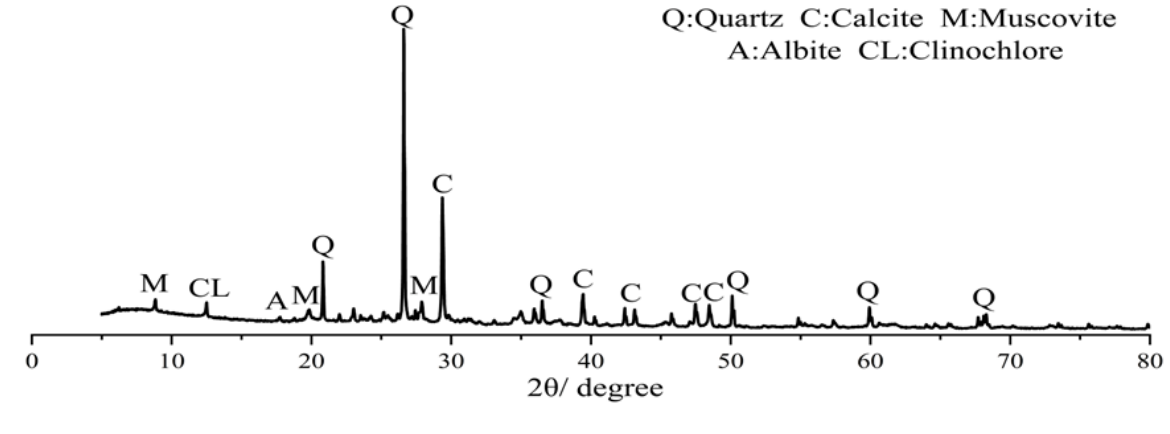
Figure 5. X-ray diffraction curves of soil.